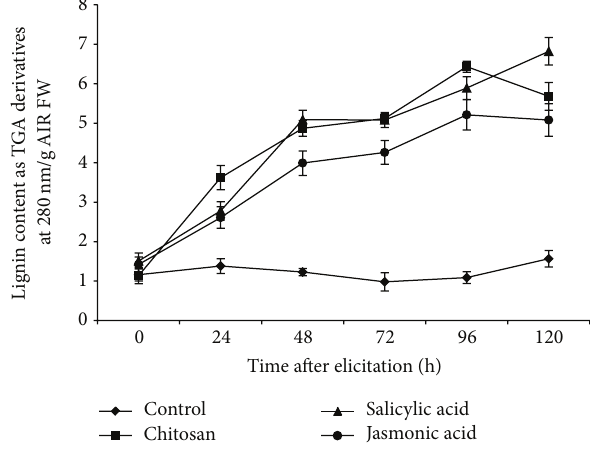
Figure 2: Deposition of lignin (expressed as thioglycolic acid derivatives at 280nm/g alcohol insoluble residue) in the cell wall on a time course after elicitation of the roots of tomato with different